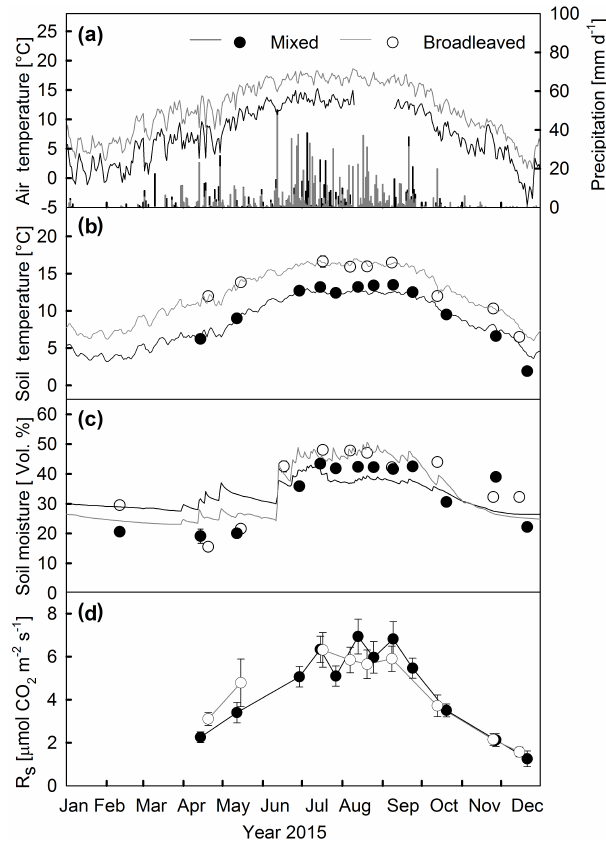
Figure 1. Seasonal course of air temperature and precipitation (a) , soil temperature (b) , volumetric soil water content (c) and soil respi- ration (d) measured at a mixed and a broadleaf forest in the Bhutan Himalayas in 2015. Circles represent daily mean values of manual measurements. Solid lines (a, b, c) represent daily mean values of continuous measurements. Error bars indicate standard error of the mean.